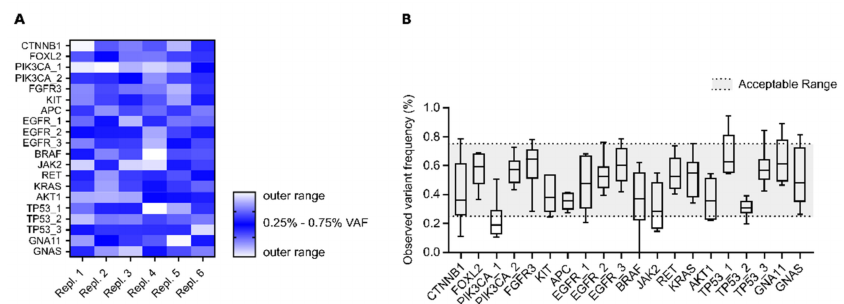
Figure 4. Reproducibility of DEEPGEN TM assay. Results of six independent replicates of a 0.5% Seraseq TM ctDNA Mutation Mix v2 reference standard were compared across 20 validated target variants. Details for each validated variant are listed in Table S3. ( A ) Heatmap representation of the six replicates with their measured variant frequencies. VAF around the expected values are shown in blue, values outside of the acceptable range (expected VAF ± 50%) in white. ( B ) Overview of all 20 validated targets (at 0.5% VAF) with their measured frequencies. The permissible range (0.25%–0. 75%) of the measured values is shown as a grey background. Box plots show the interquartile range (IQR) with whiskers representing the range of the 5–95 percent confidence interval.